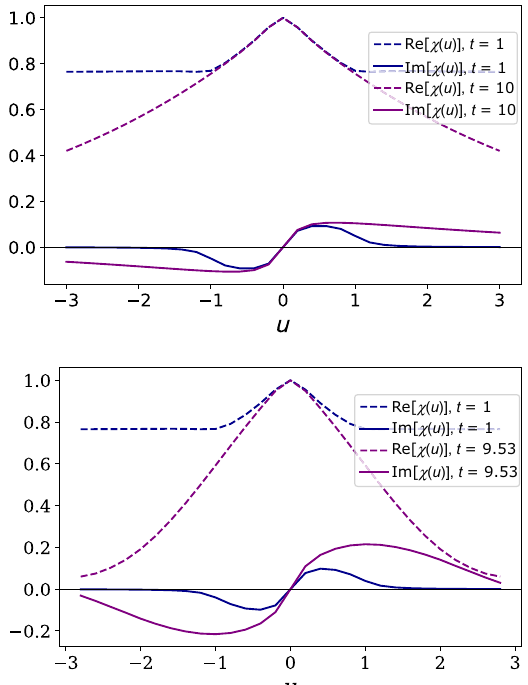
FIG. 11. Top: asymptotic mean heat for the independent- boson model as a function of K . Bottom: asymptotic variance of the heat distribution for the independent-boson model as a function of K . Triangles represent the analytical solution given by Eq. (45) (top) and Eq. (47) (bottom) in the long-time limit. The figures are plotted for different values of the temperature and coupling strength. The remaining parameters are set to ω C = 5, (cid:6) = 0.01, p = 100, and u =